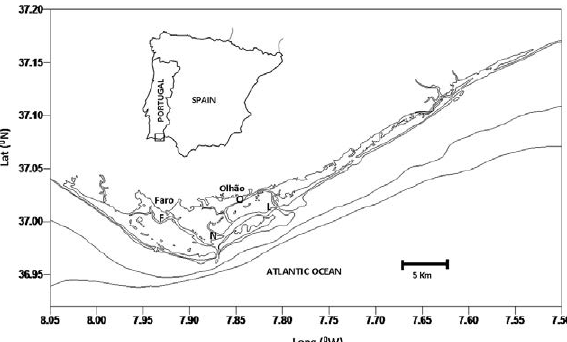
Fig. 1. – Ria Formosa: sampling sites F, O and L for sediments and clam Ruditapes decussatus ; natural banks of clams (N), and location of cities of Faro and